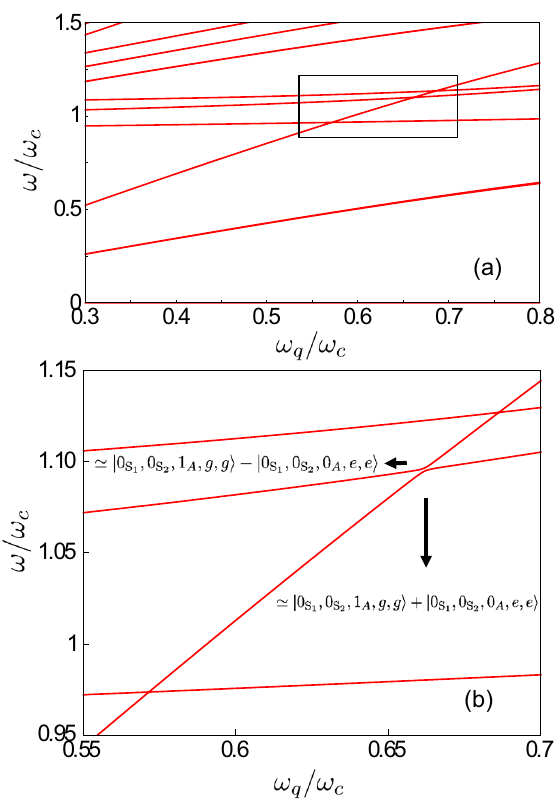
ω i ω 0 for the lowest-energy dressed states of H ′ as a function of the = − 0 ). We set the normalized qubit-resonator = /ω c 0.3 and J /ω c 0.05 , respectively. g ≡ | | = = π , while the longitudinal interaction 0 and ϕ 3 = = π/ 6 . ( b ) Enlarged view of the inset in ( a ). When = π ), the avoided level crossing results 0, ϕ 3 = = , 1 A , g , g , 0 A , e , e , 0 S , 0 S 0 S 0 S and , due to the presence of counter- 2 2 1 1 � � | | ω A / 2 . The ≃ / 2 and ω q / 2 , ω S ω S 1 2 ≃ ≃ , 0 A , e , e , 0 S 0 S , indicates that the two qubits do not couple with the two symmetric 2 1 � |